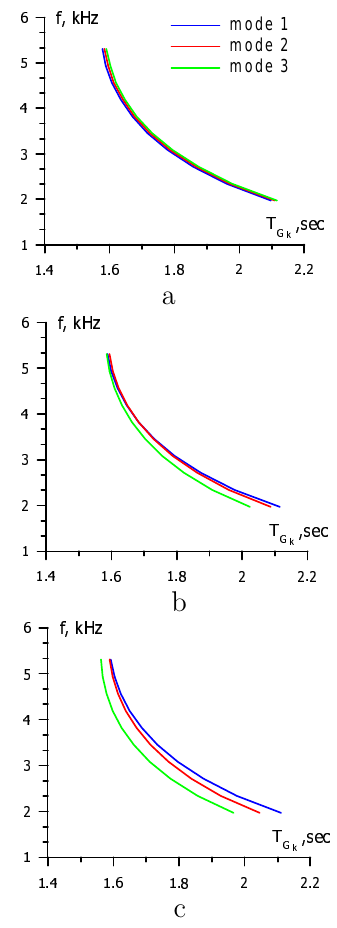
Fig. 5. The group delay time for eigenmode propagation from the equator to the ionosphere at magnetic shell L =4 ( F BL =13.5kHz) for different values of the duct radius in the equa- torial plane: a − a L ≈ 90km, b − a L ≈ 30km, c − a L ≈ 20km plasma density: N dL ≈ 510cm − 3 , N ∞ L ≈ 330cm − 3 ( 1 ≈ 1.55) Eigenmode indexes are shown on the legend. Narrow duct case, plane ( c ) : Sep- arate components, corresponding to the particular eigenmode, are more pronounced in a signal; propagation time decreases with in- crease in the mode index. Wide duct case, plane ( a ) : Components are less pronounced; propagation time increases with an increase in a mode